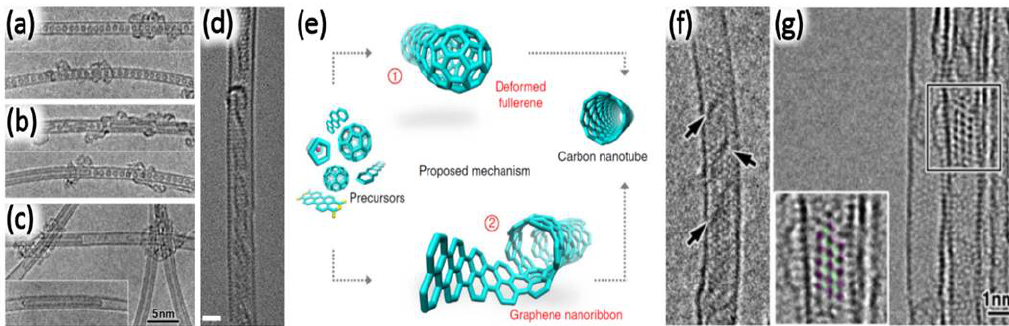
Figure 7. Various molecular encapsulated SWNT for DWNT preparation. TEM image of ( a ) pea pod (C 60 @SWNT), ( b ) intermediate structure and ( c ) completed transformation into